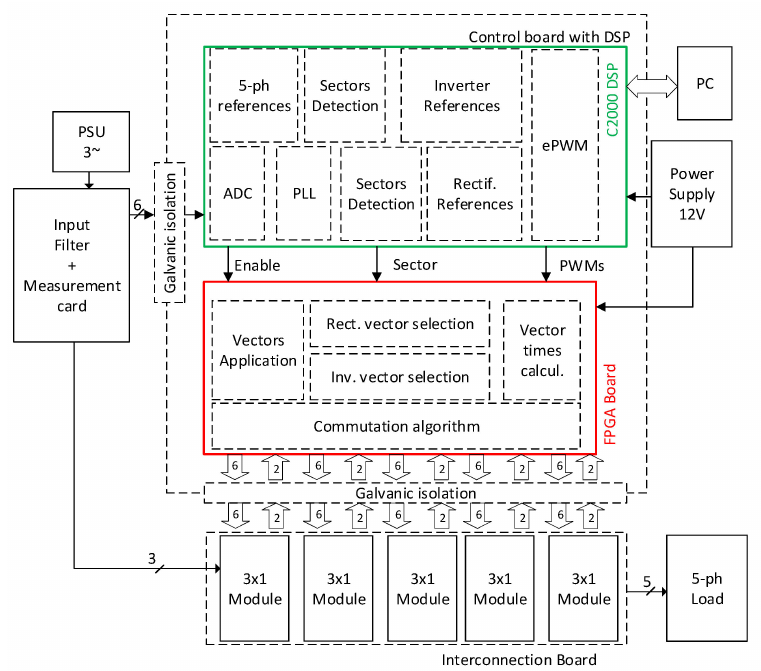
Figure 10. Block diagram of the presented 3 × 5 matrix converter prototype.